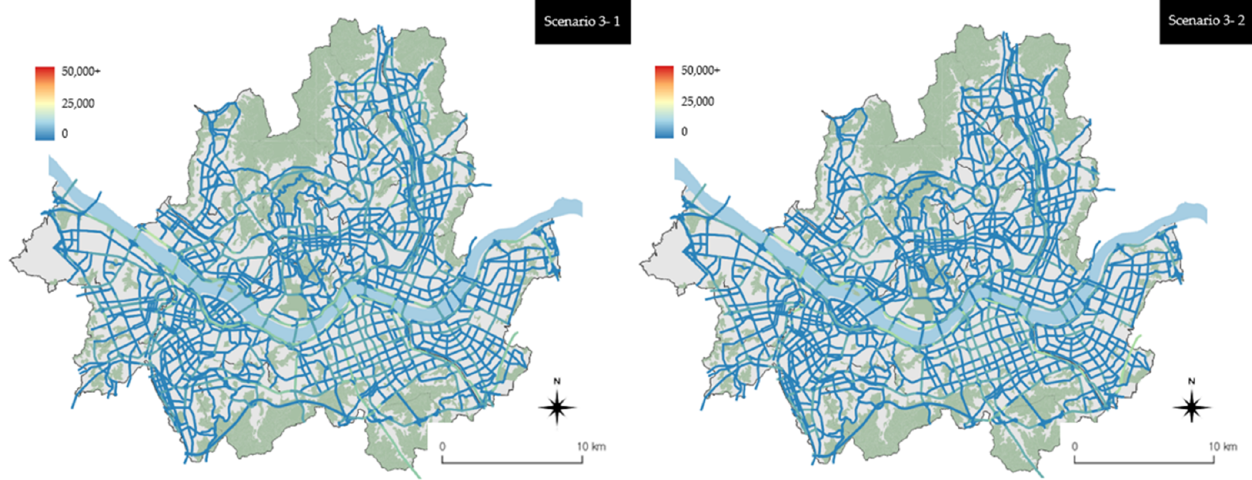
Figure 9. Scenario 3 vehicle emissions by the link units (using the existing range of the legend).